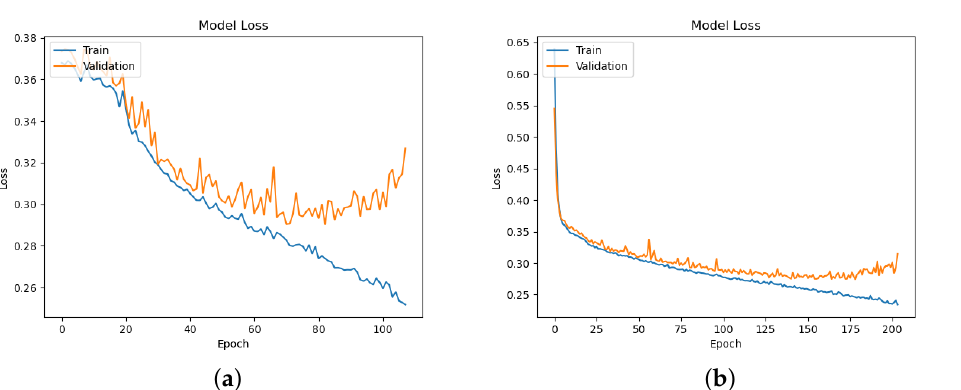
Figure 7. Learning curve of the loss function: ( a ) Original HED architecture; ( b ) Modified HED